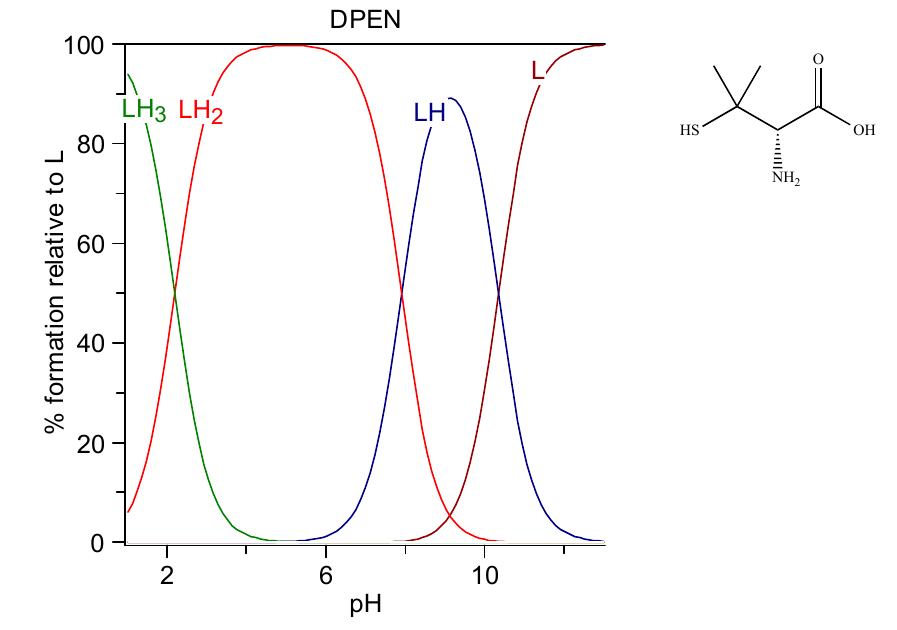
Figure 6. Speciation plots of D ‐ penicillamine (DPEN).